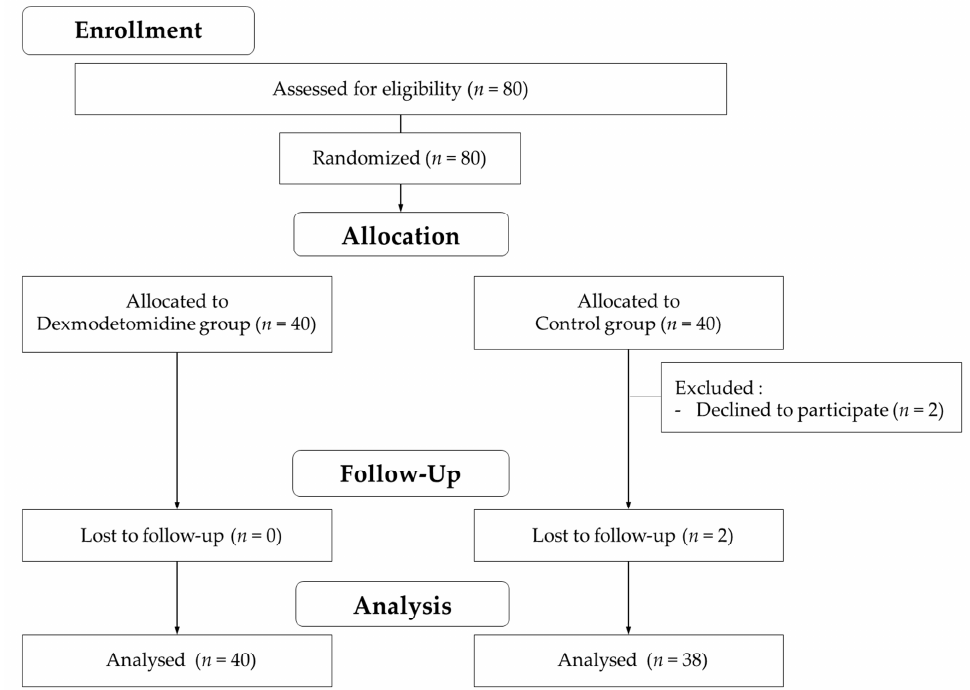
Figure 1. Patient enrollment flow.